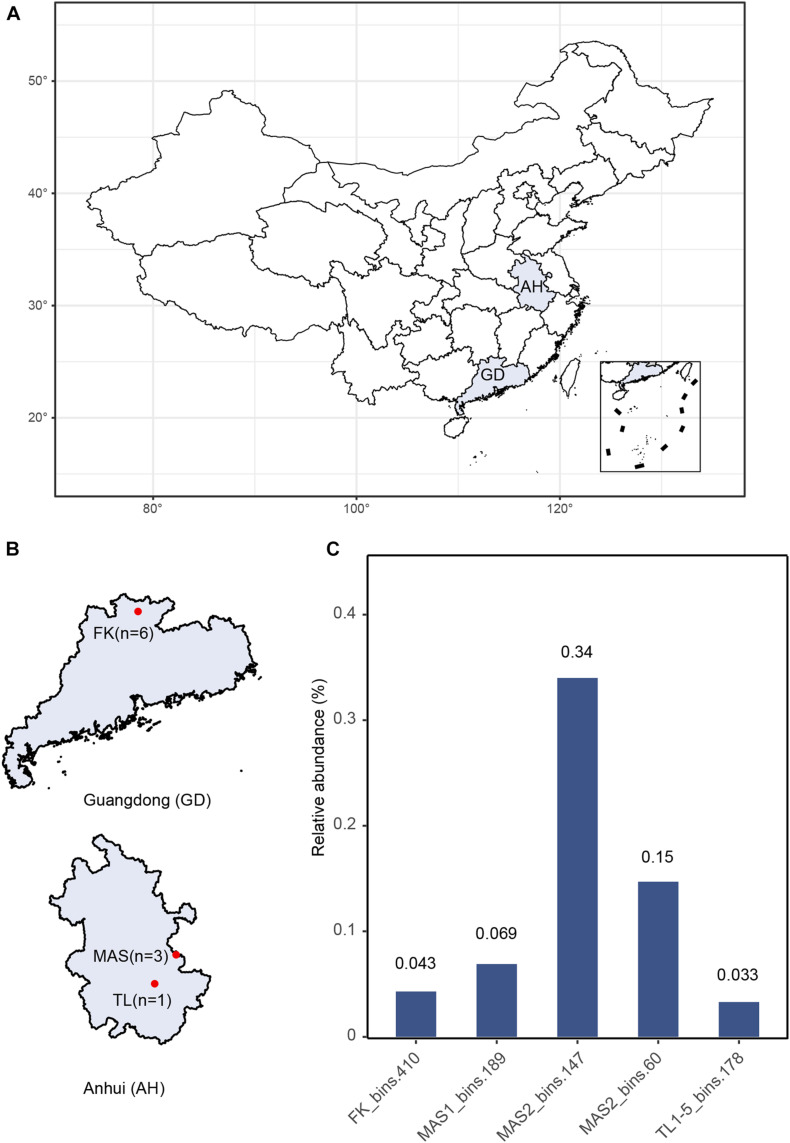
(A) Geographic locations of sampling sites. (B) Details of sampling sites and the number of samples. (C) Relative abundance of newly recovered MAGs, calculated by the abundance of the all scaffolds of each MAGs over the abundance of all scaffolds in corresponding samples.